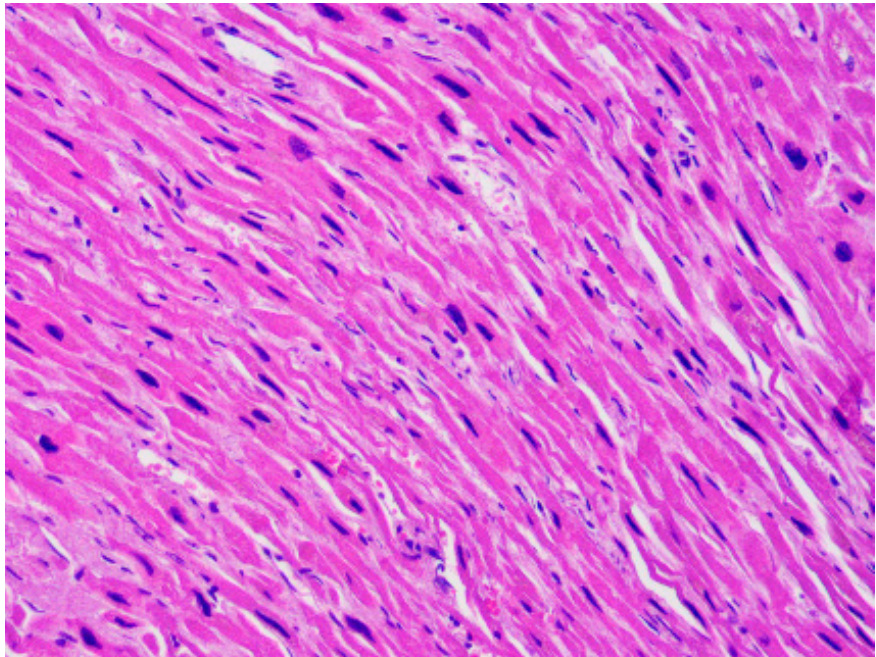
Figure 5. Mild fibrosis and increased nuclear-cytoplasmic ratio in the cardiomyocytes of the heart of a 45-year-old woman affected by dilated cardiomyopathy (hematoxylin and eosin stain, 40 × magnification).